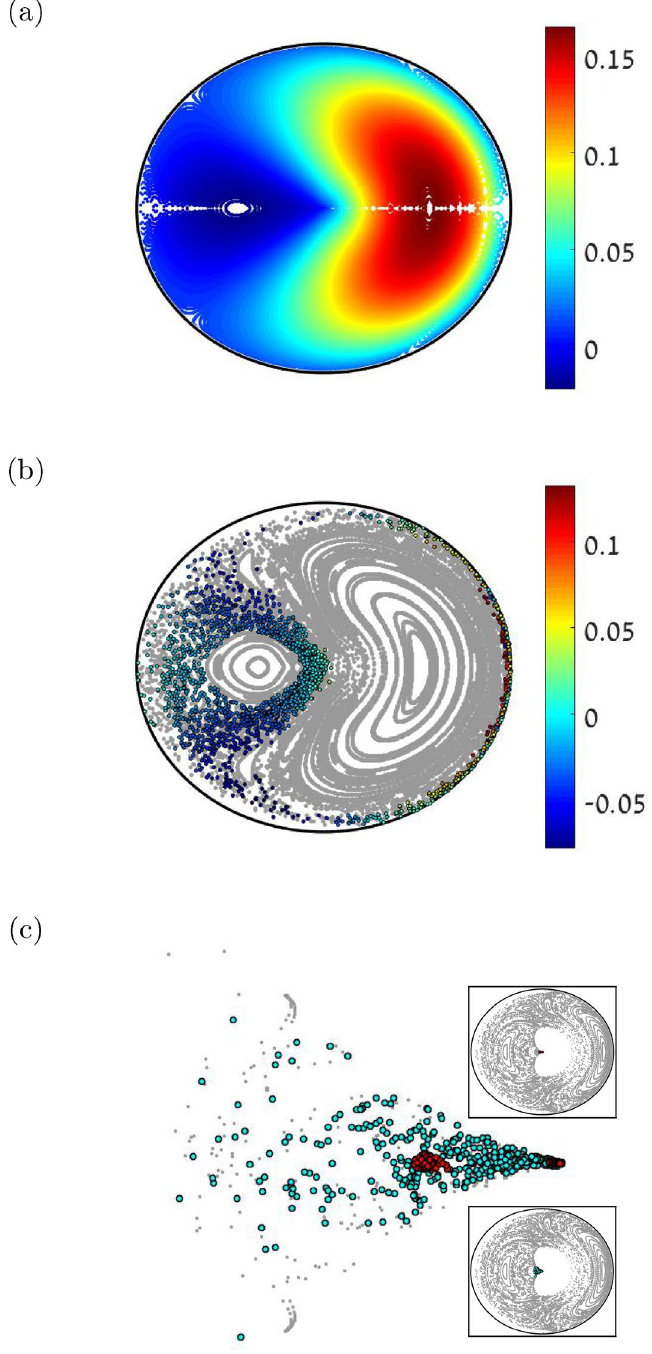
Figure 5. Spreading and depletion. ( a ) Image of M for the phase space points of the energy surface H ( 0 ) (ϕ , n � swp . ( b ) Poincare section for the same (cid:31) 1.61 π 2.3 and � M ) E 0 . The interaction is u = ∼ = ; = at the same energy (gray trajectories), and a spreading cloud (colored trajectories) following a quench to this (cid:31) value. The initial cloud is the preparation at n 0 . It spreads away from the central SP, and stretches along = the chaotic corridor. Its points are color-coded by M . ( c ) The spreading cloud in the sweep simulation. Upper (cid:31) stb . An inner piece 3 π 10 − 4 (slow). The snapshot is taken at (cid:31) inset (red points): The sweep rate is ˙ � = · ∼ 0 stability island, and therefore has energy close to E 0 . An outer piece of the cloud is still locked in the tiny n = of the cloud was formed due to very slow spreading in the chaotic corridor, and therefore has lower energy. The Poincare section at the background is adjusted to this lower energy. Lower inset (blue points): The further (cid:31) stb and wait to see further ergodization in the evolution of the same cloud after we stop the sweep at (cid:31) = chaotic strip. The upper inset would look like that if the sweep were much slower. Main panel: Zoom that displays the red and the blue clouds of the